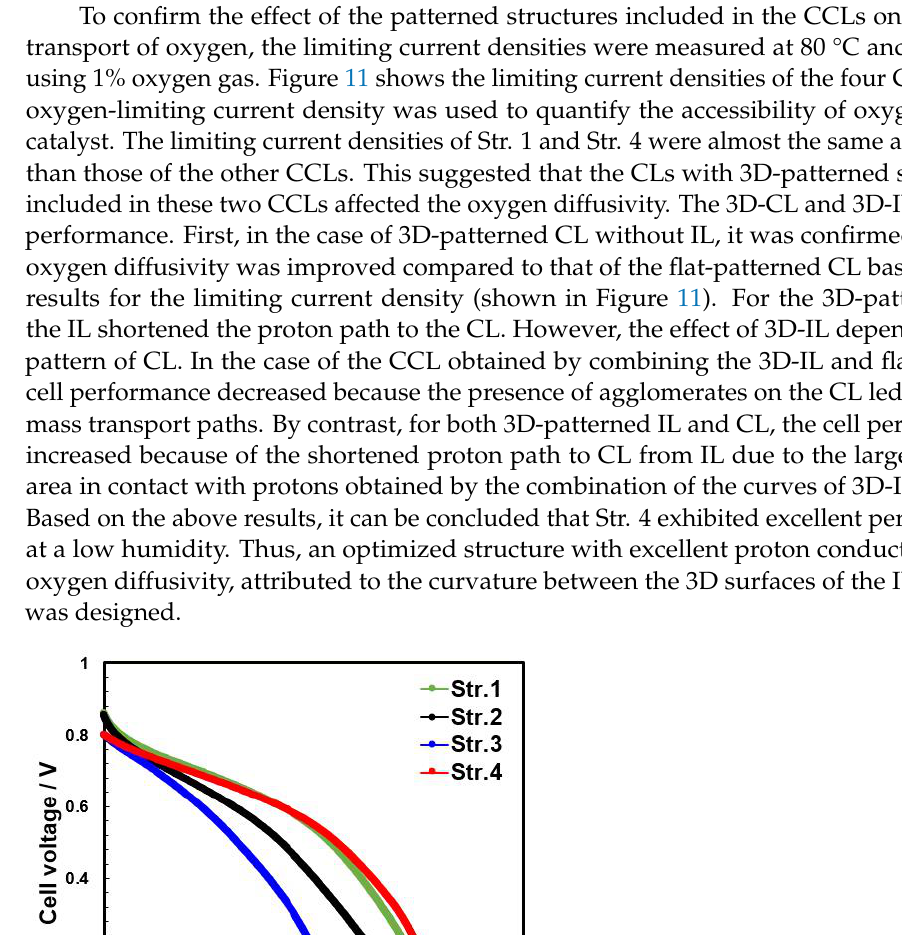
Figure 11. Limiting current densities of the four CCLs using 1% oxygen gas at 80 ℃ and 95% RH.